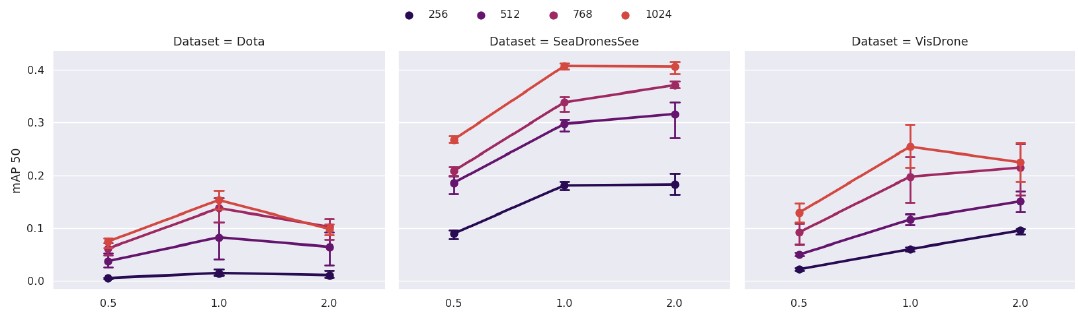
Figure A10. Image Size: YoloV4 trained with different training image sizes and validated on validation image size = x × training image size. The y-axis shows the mean Average Precision